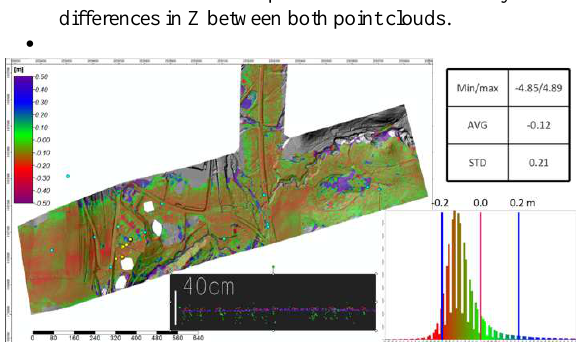
Figure 10: Grid differences between Puck and VQ480 DTM (top left) with a histogram (bottom right) and cross-section (bottom center). On the cross section, red dot is VQ480 and green represents Puck cloud. GCP’s are the blue and yellow dots (blue=static GNSS, yellow=RTK GNSS)